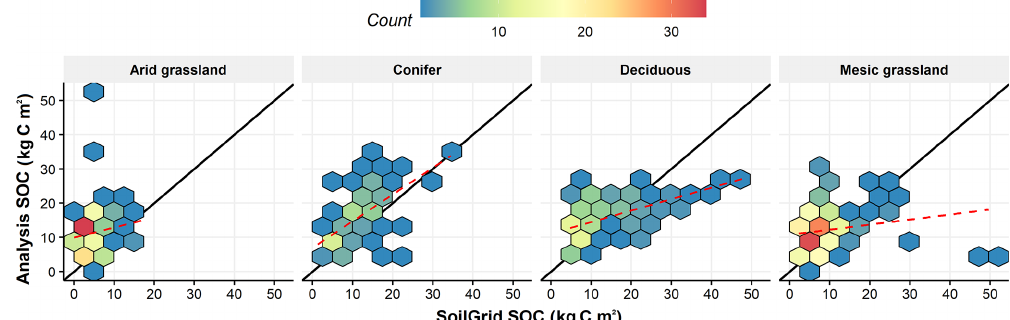
Figure 9. Soil organic carbon analysis comparison to the SoilGrids database for different plant functional types. The solid back line represents the one-to-one line, and the dashed red line is the linear regression line between reanalysis SOC in this study and SoilGrids SOC.